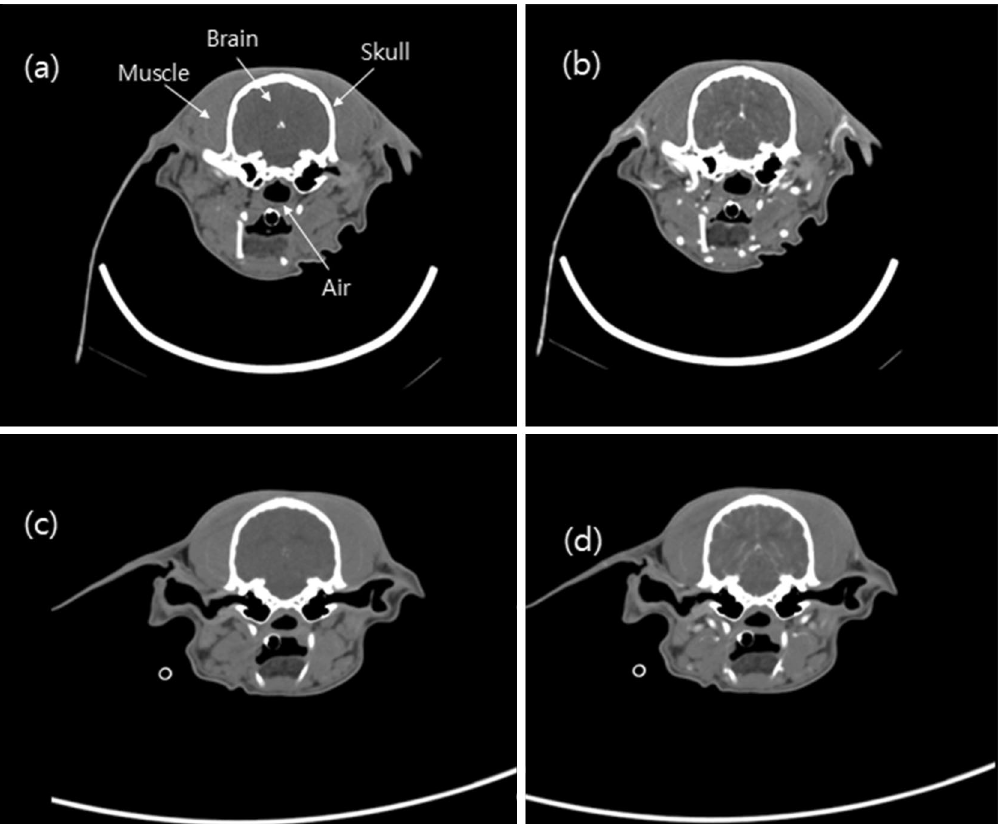
post-contrast axial image of the head in the EID system (140 kVp, 100 mAs, CTDIvol: 41.7 mGy, slice thickness: 2.0 mm, display window: W/L = 450/100